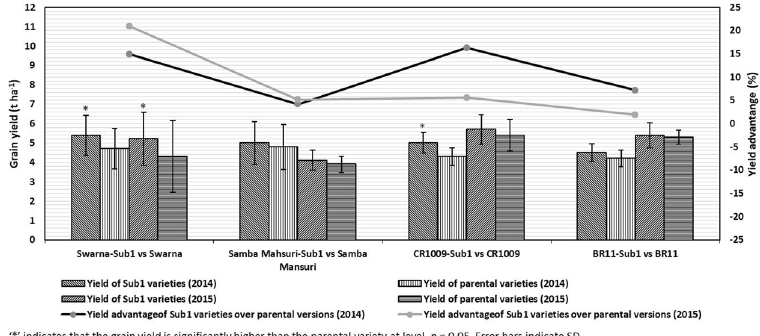
Figure 1. Comparison of mean grain yield (over locations) of Sub1 varieties and their recurrent